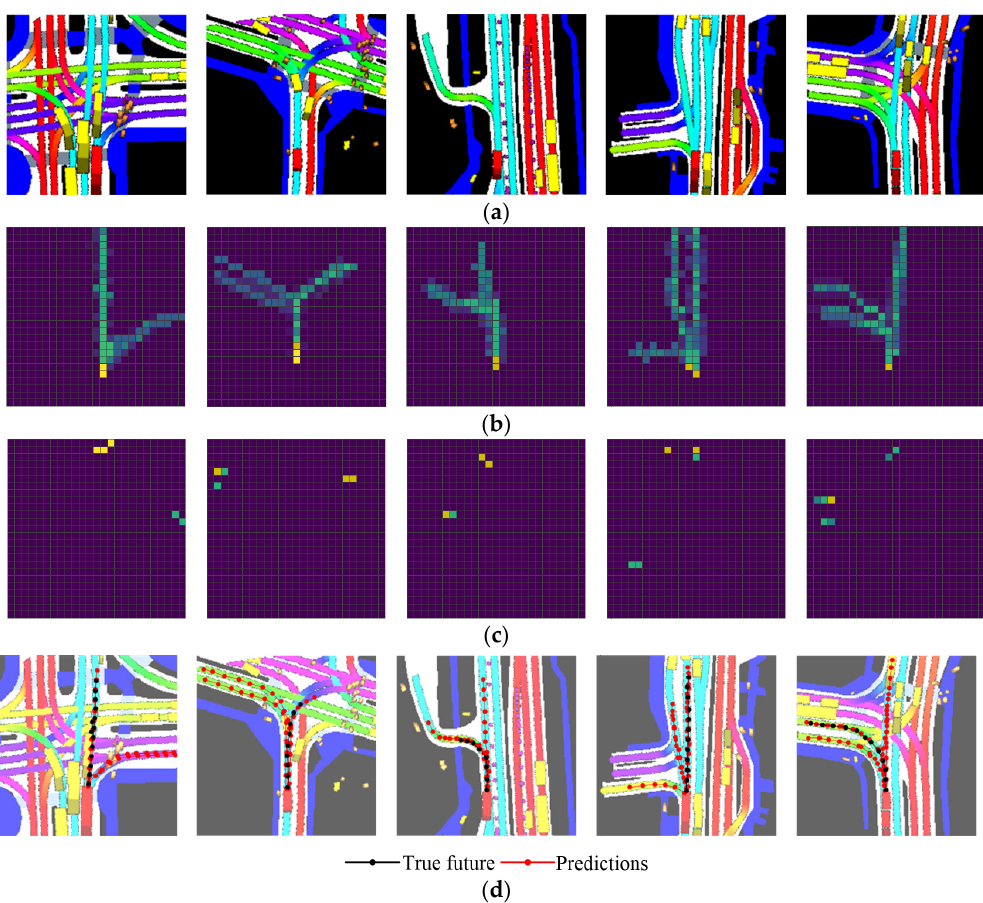
Figure 11. Visualization examples from nuScenes. ( a ) Raster image input; ( b ) Path SVF images; ( c ) Goal SVF images; ( d ) Predicted trajectories.